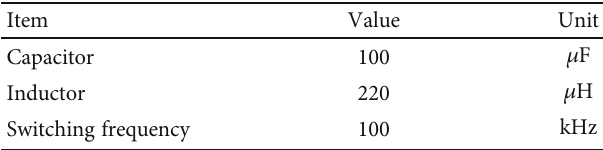
Figure 13: MOSFET failure in converter. Table 3: Boost converter speci fi cations.